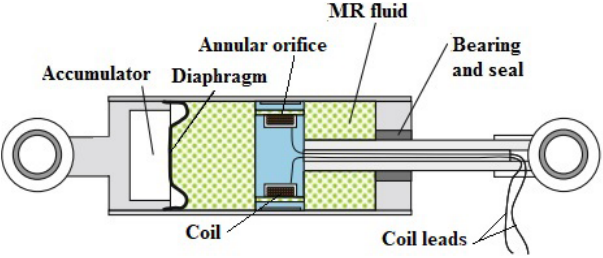
Figure 1. Cross section of the MR damper